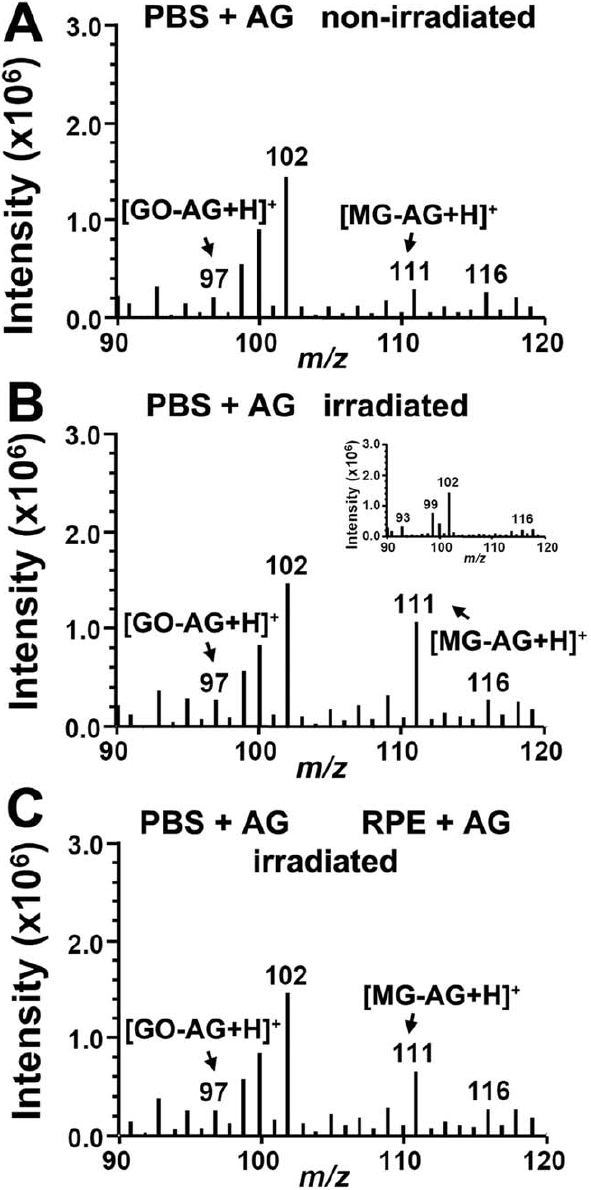
Figure 6. Positive ESI-MS spectra indicating release of methyl- glyoxal (MG) into the extracellular milieu following photode- gradation of intracellular A2E. Pretreatment of the cells with aminoguanidine (RPE-AG) reduces this release. Extracellular trapping by aminoguanidine in PBS (PBS-AG). ( A ) PBS-AG recovered from ARPE19 cells that had accumulated A2E (A2E-ARPE19) and were not irradiated. ( B ) Recovered PBS-AG that had overlaid A2E-ARPE19 cells during irradiation. Note increase in MG-AG adduct ( m/z 111; [M + H] + ). Inset , ESI- spectra (direct injection) obtained with ethylacetate only. The prominent m/z 102 peak attributable to ethylacetate serves as an internal control ( C ) Aminoguanidine-containing PBS that had overlaid irradiated A2E-ARPE19 cells pre-treated with aminoguanidine. GO-AG adduct, m/z 97; [M + H] + ; MG-AG adduct, ( m/z 111; [M + H] + .